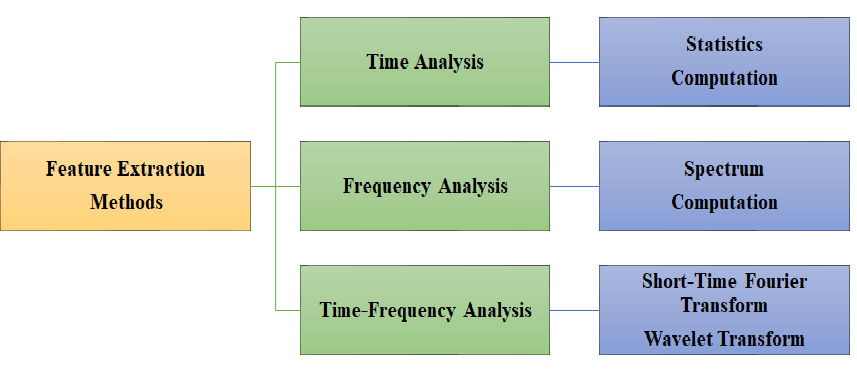
Figure 5. Overview of signal representation techniques commonly used for road surface anomaly detection systems, classification systems, and feature